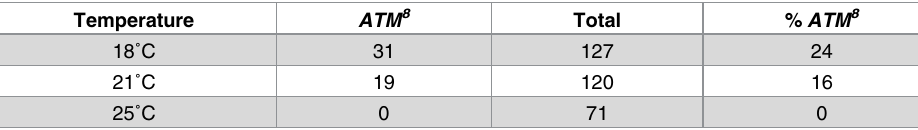
Table 1. Effect of temperature on ATM 8